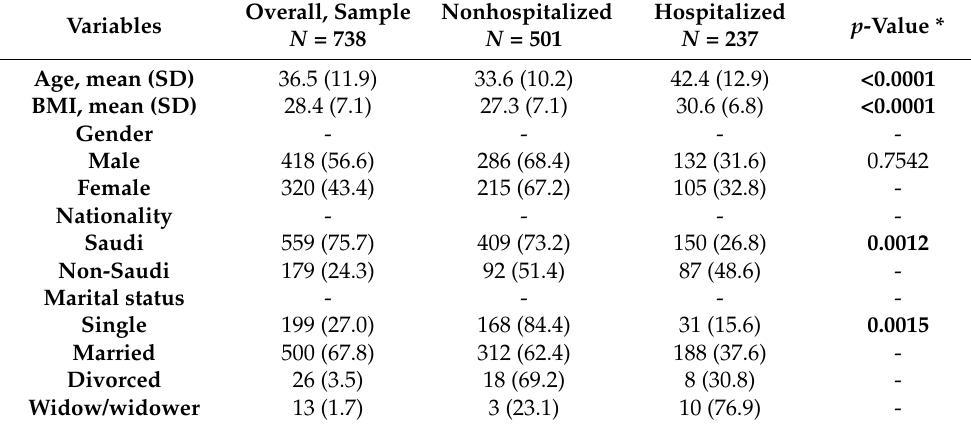
Table 1. Patient demographics.